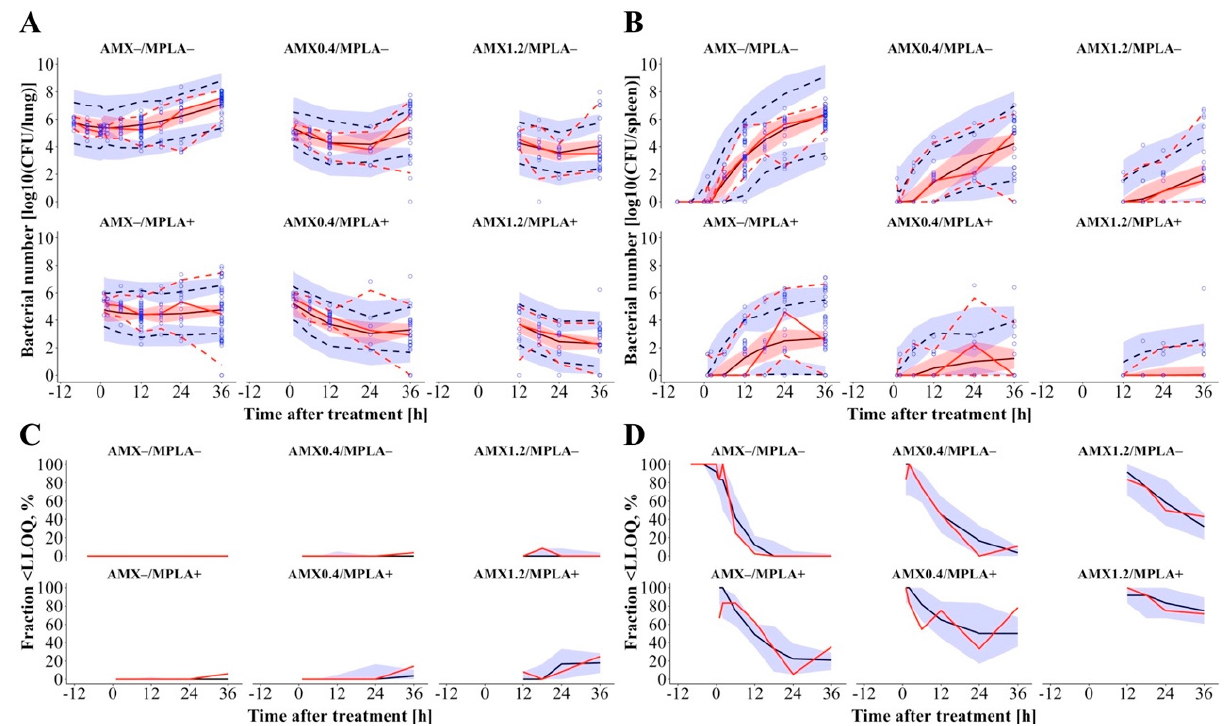
Figure 2. Visual predictive check (n = 1000 simulations including unexplained variability) of the pharmacometric pharma- cokinetic/pharmacodynamic model for bacterial numbers in lung ( A ) and spleen ( B ) stratified into study groups including the fractions of samples being below the LLOQ for lung ( C ) and spleen ( D ). Circles: Observations; Lines: 50th percentile (solid), 5th and 95th percentile (dashed) of observed (red) and simulated (black) bacterial numbers. 90% confidence interval around simulated percentiles as shaded area. Abbreviations: AMX: Amoxicillin (0.40 mg/kg or 1.20 mg/kg); LLOQ: Lower limit of quantification; MPLA: Monophosphoryl lipid A (2.00 mg/kg); +: Treatment with respective drug; –: No treatment with respective drug.